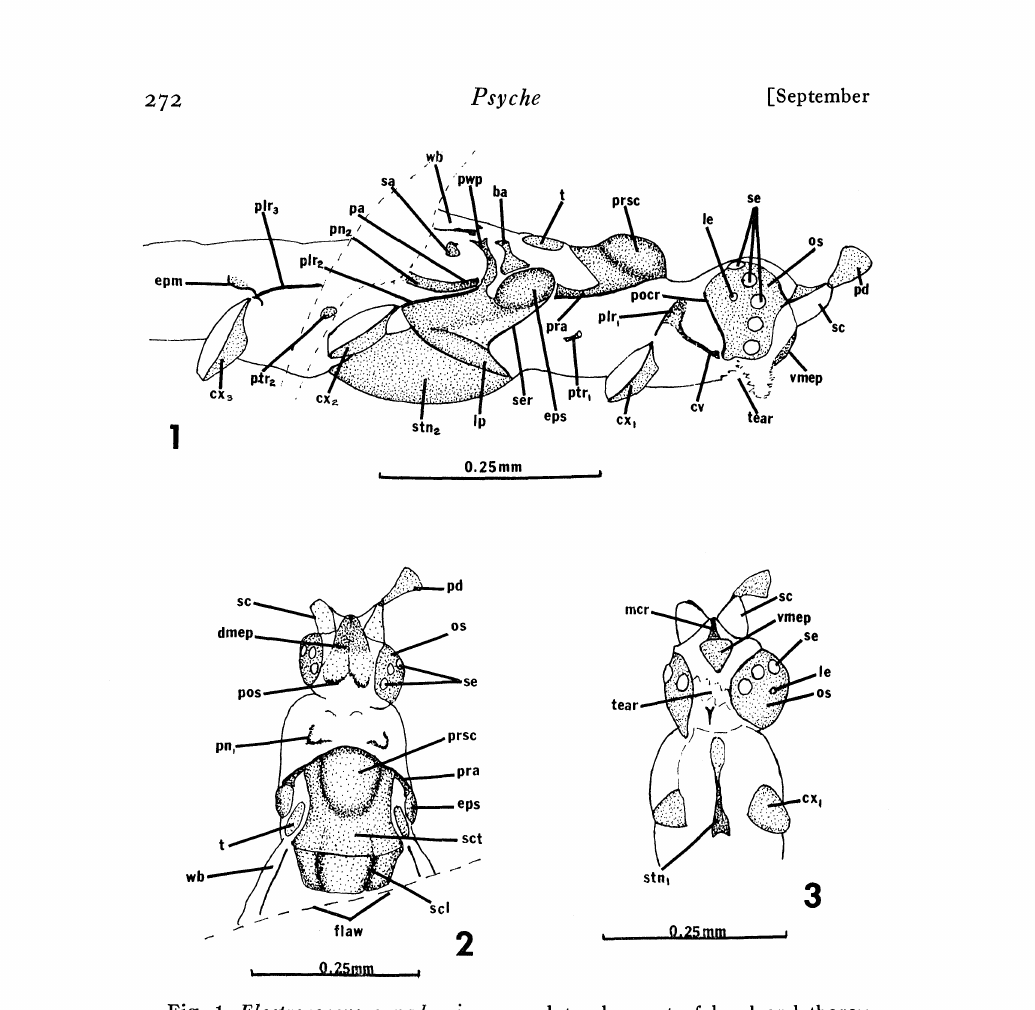
Fig. 1. Electrococcus canadensis n. sp., lateral aspect of head and thorax. Fig. 2. Dorsal aspect o head and thorax. Fig. 3. Ventral aspect of head and